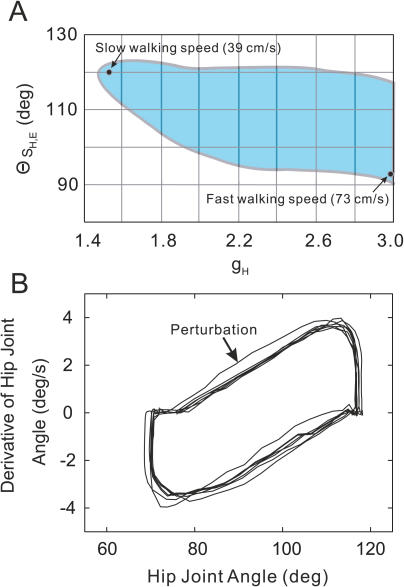
The Stable Domain of the Controller Parameters and the Stability Analysis(A) The shaded area is the stable domain of the controller parameters (ΘSH,E , gH), where stable gaits will appear in experiments performed with the real robot.(B) Limit cycles in phase plane dΘSH/dt, ΘSH for walking on a flat floor (ΘSH,F = 78.0°, ΘSK,F = 115.0°, ΘSH,E = 105.0°, ΘSK,E = 175.0°, gK = 1.8 and gH = 2.2). It shows that after being perturbed, the walking gait returns to its limit cycle quickly in only a few steps. Note that RunBot can neither detect the disturbance nor adjust any parameters of its controller to compensate for it.